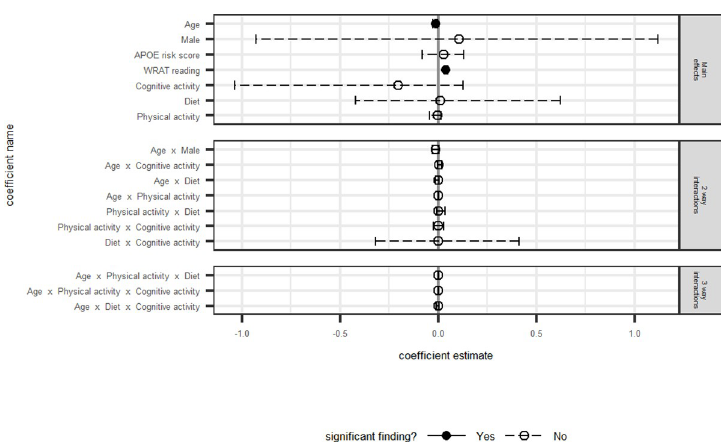
Fig 2. Immediate memory: Model averaged regression coefficient estimates and 95% confidence